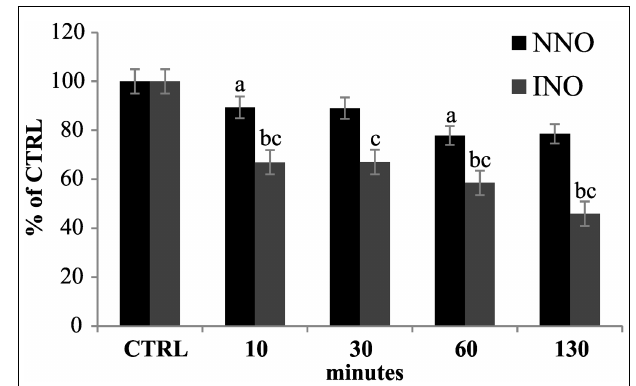
FIGURE 5 |Time dependence of cPTIO EPR signals in seedlings. 8-day-old Arabidopsis seedlings were incubated in 50 ml of liquid culture medium. cPTIO(NNO) or (INO) was added to the supernatant and aliquots of the medium were taken at indicated time points. EPR measurements are presented as percentage of the total signal resulting from measurement of 100 μ M cPTIO(NNO) and (INO) dissolved in water (CTRL) ± SD. A Student’s t -test was performed for each experiment and statistically significant data marked: (a) p < 0.01 cPTIO(NNO) compared with the previous time point, (b) p < 0.01 cPTIO(INO) compared with the previous time point, (c) p < 0.01 cPTIO(INO) compared with cPTIO(NNO) at the same time point.